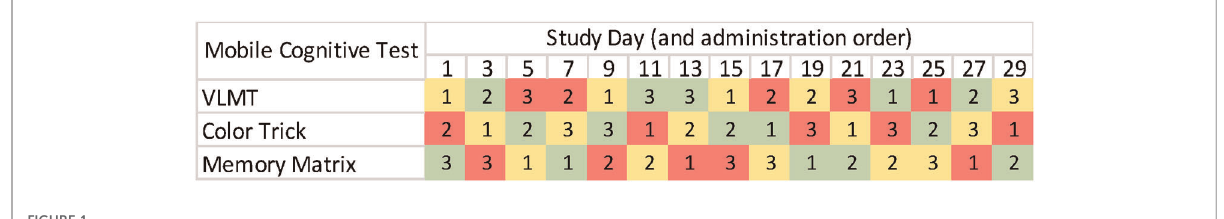
FIGURE 1 Protocol of mobile cognitive testing administration. Note. Dif fi culty levels are depicted as green (easy), yellow (medium), and red